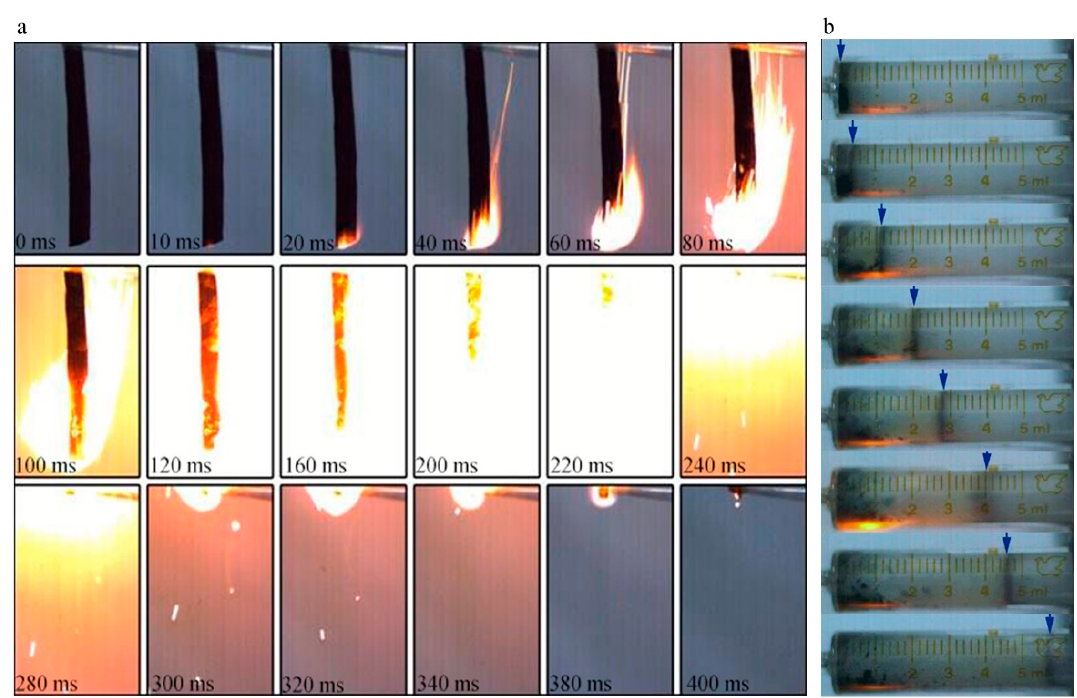
Figure 8. ( a ) The combustion images of NGO; ( b ) the photographs of work experiment.